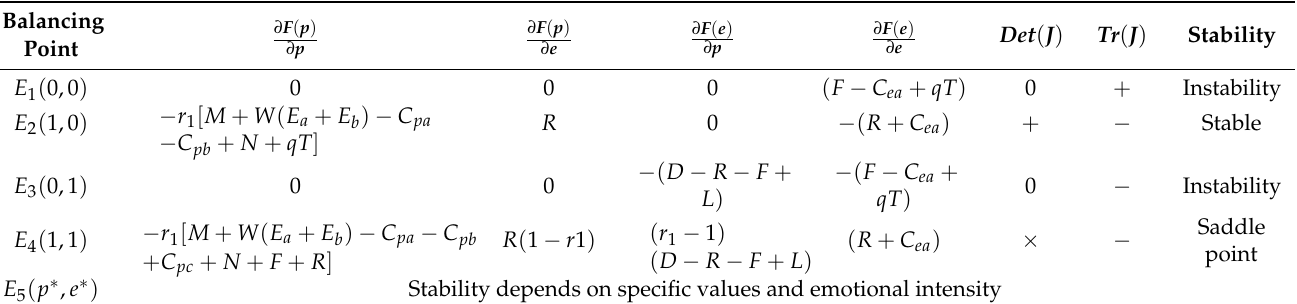
Table 8. Strategy combination stability analysis under shared manufacturing supply chain emotion, shared platform rationality